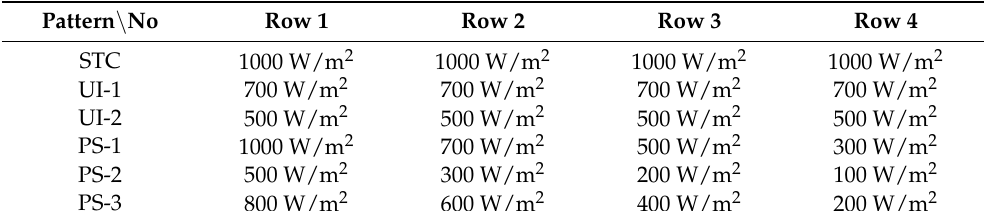
Table 3. Irradiation profile.